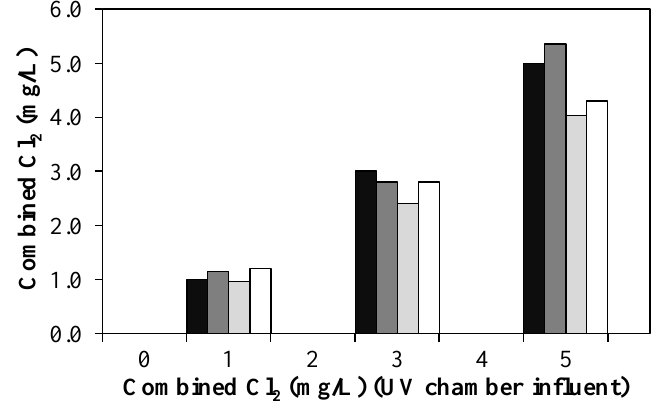
Figure 6. Combined Cl 2 in the UV chamber influent ( ) and pilot plant effluent after treatment of 1 m 3 /h NH 4+ -loaded WWTE with CC (no UV) ( ), UV/CC (0.4 kW, no quenching) ( ) and UV/CC (0.4 kW, 3.0 – 4.5 mg/L H 2 O 2 quenching) ( ) by means of an AOP pilot plant (Exp. C).